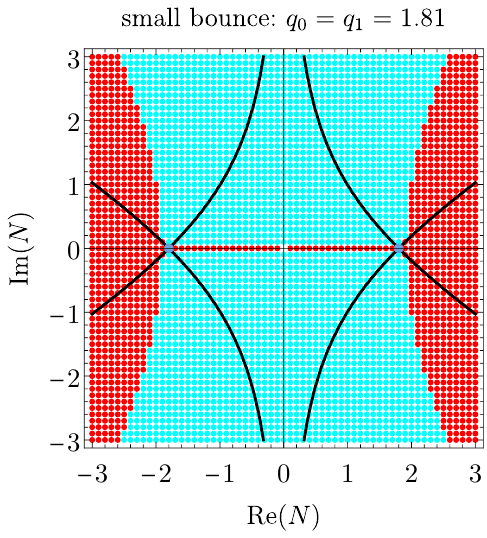
Figure 9 . Classical transition with q 0 = q 1 = 1 . 81 . The saddle points (in blue) — which correspond to classically bouncing backgrounds — are reachable by allowable metrics along the steepest descent contours (in